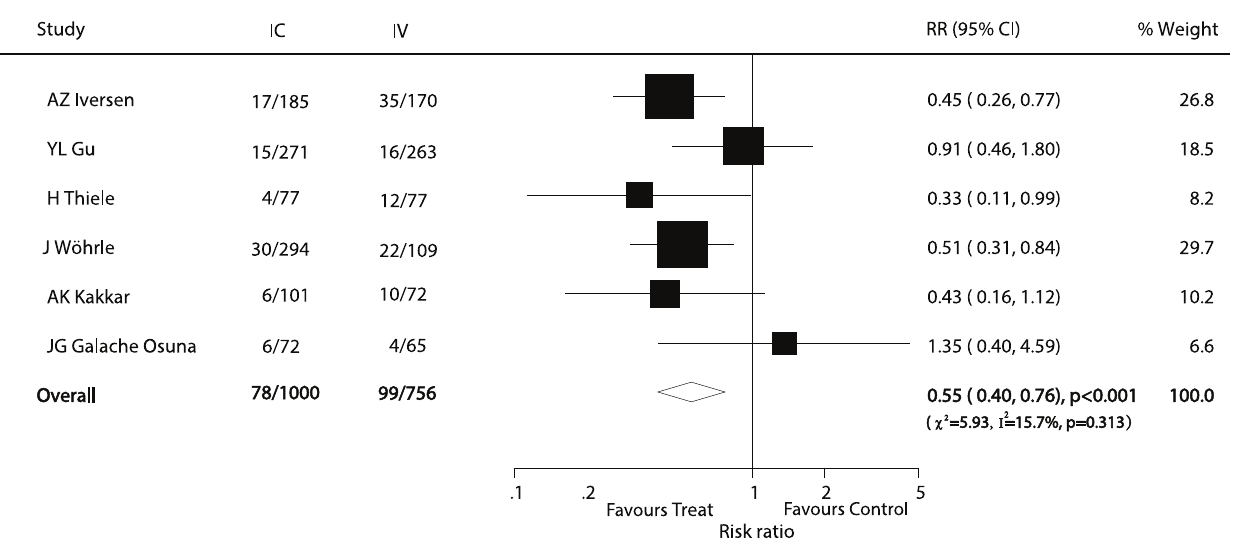
Figure 2. Effects of IC administration of abciximab on risk of major cardiovascular events as compared to IV therapy in patients with ACS.